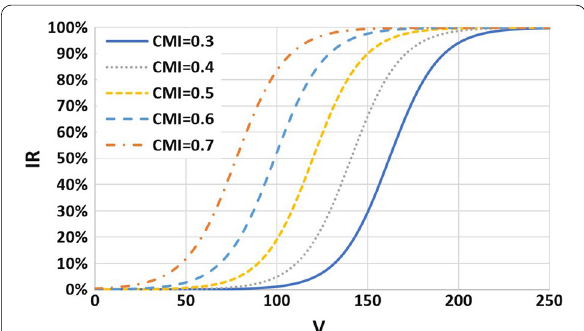
Fig. 3 Example model for frontal impacts where IR continuously varies as a function of CMI and V r , based on the results by Gulino et al.